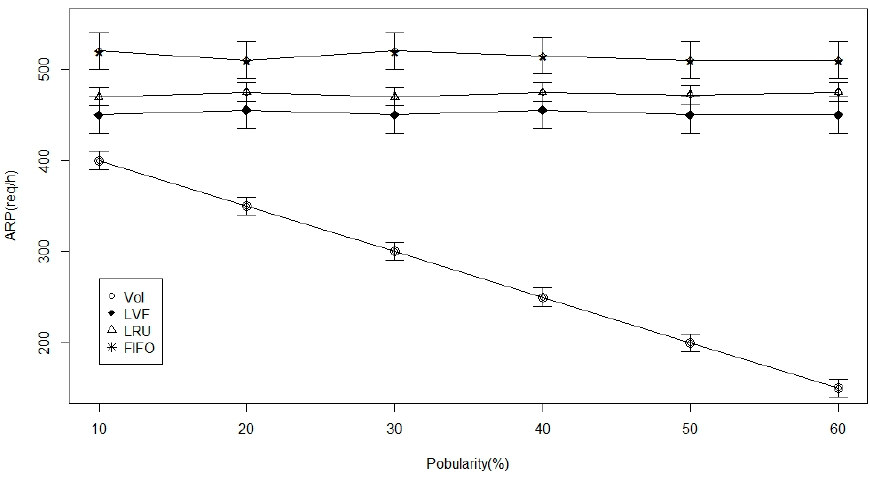
Figure 11. Publisher load versus the data popularity.